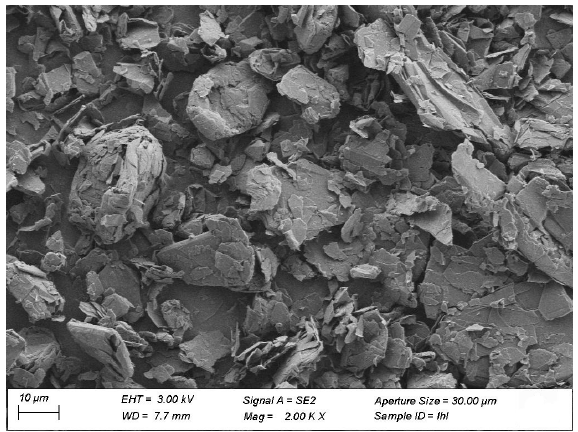
Figure 1. SEM (scanning electron microscopy) morphology of graphite powders.